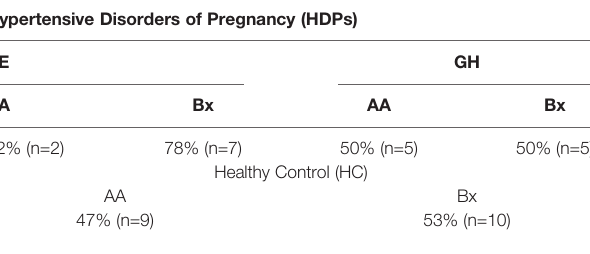
TABLE 3 | The AA to Bx KIR phenotype ratio in HDPs and control women. Hypertensive Disorders of Pregnancy (HDPs)